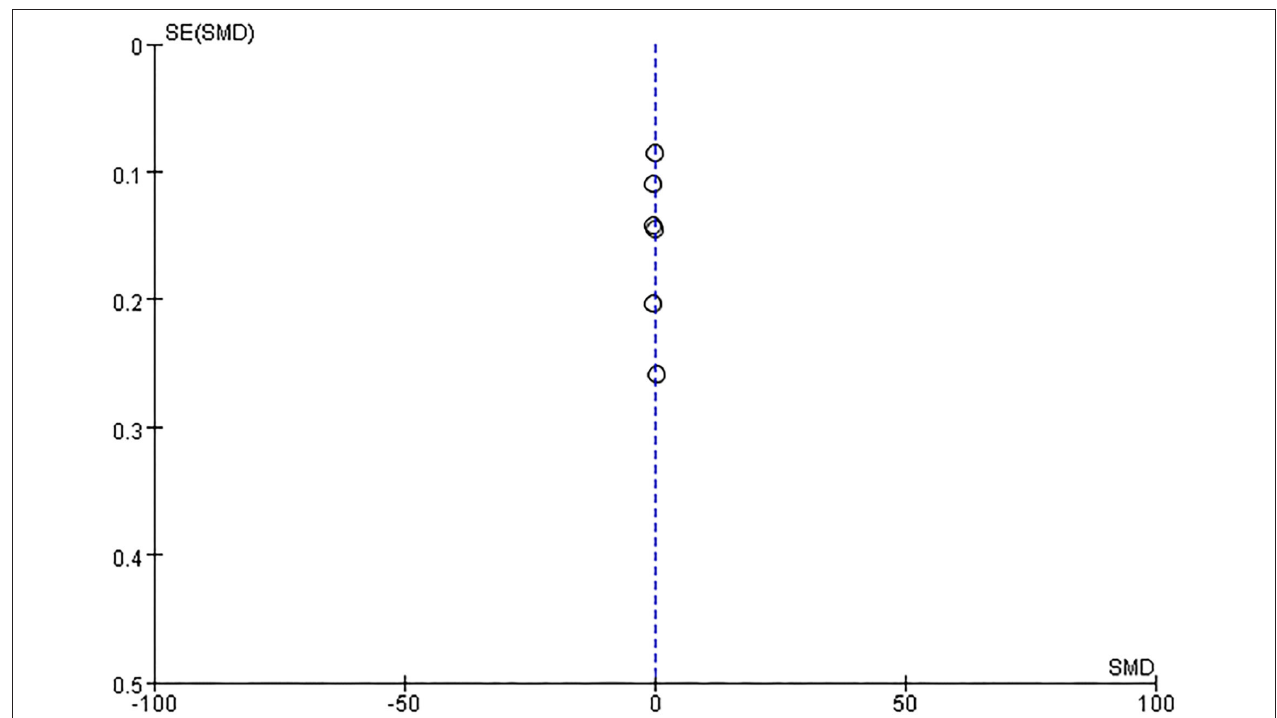
FIGURE 8 | Funnel plot of comparison: ESD care vs. usual care, outcome: length of hospital stay.